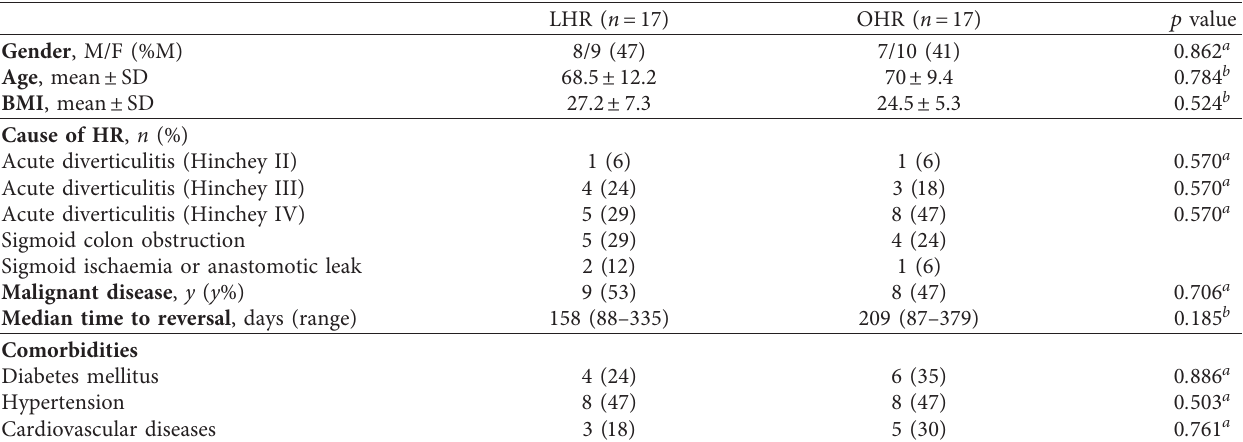
Table 1: Patient’s